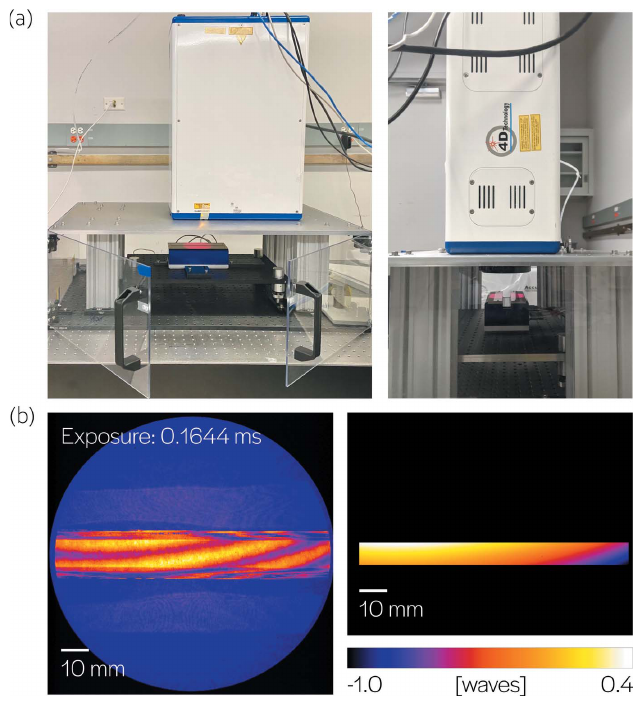
Figure 2 Experimental setup. ( a ) Mirror surface profiling with a Fizeau interferometer ( (cid:2) = 658 nm) mounted vertically above the bimorph mirror. ( b ) An example interferogram. Four such measurements are acquired simultaneously and used to recover a surface profile, which is cropped to the active area of the